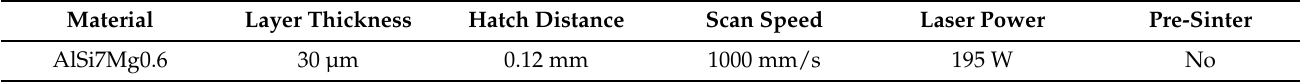
Table 2. Bulk scan